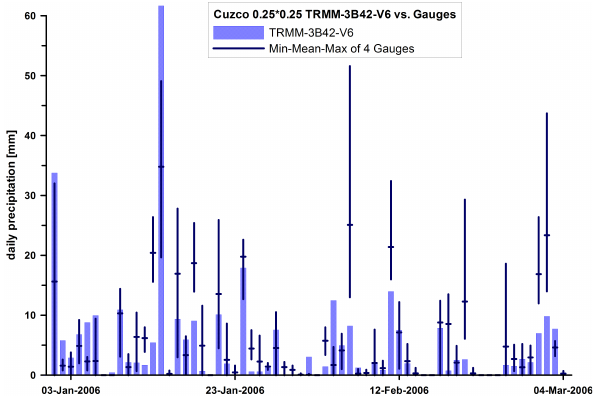
Fig. 3. Comparison of TRMM 3B42 V6 and gauge daily pre- cipitation for Cuzco, Peru (January to March 2006). Shown are the arithmetic mean, maximum and minimum of the ground truth (4 gauges).